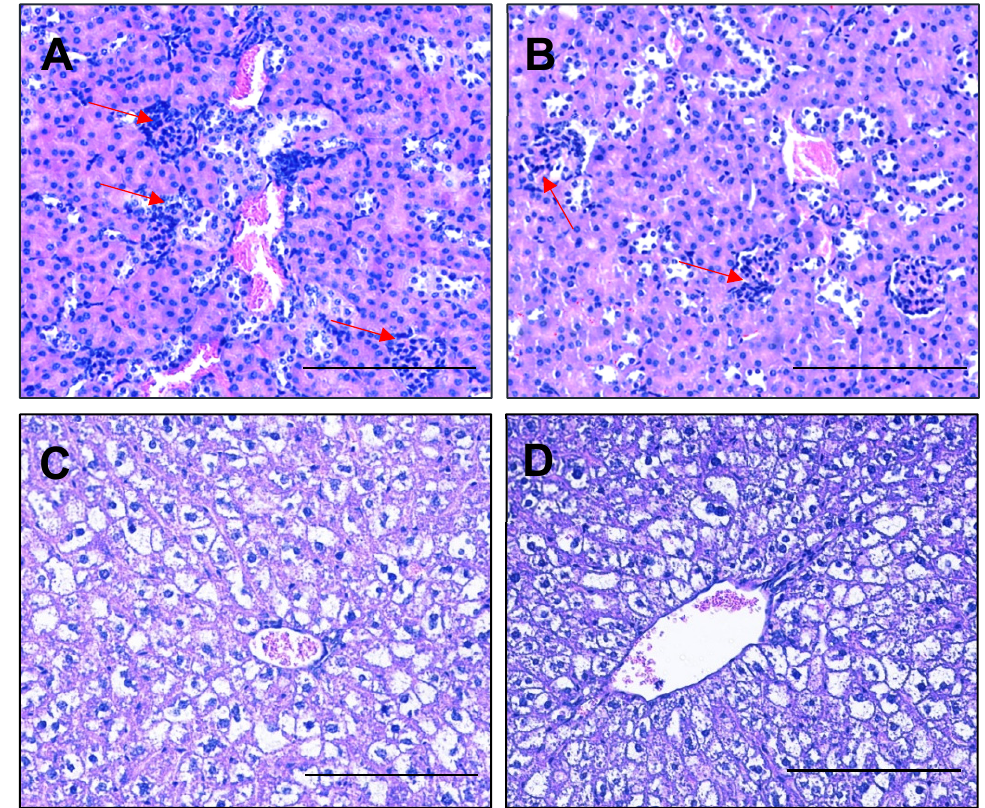
Figure 10. Pathological changes in the kidney and liver of high fat diet L-NAME mice are not improved by esomeprazole treatment. Haematoxylin and eosin-stained kidney sections demonstrated enlarged glomeruli, narrowing of the Bowmen's capsule space, and immune infiltrations into the glomeruli (red arrows). However, these were found in both the control ( A ) and esomeprazole treated ( B ) mice. Livers from the high fat diet L-NAME mice had steatosis with nuclear displacement ( C ), which was not improved with esomeprazole treatment ( D ). Scale Bar = 100 µm.